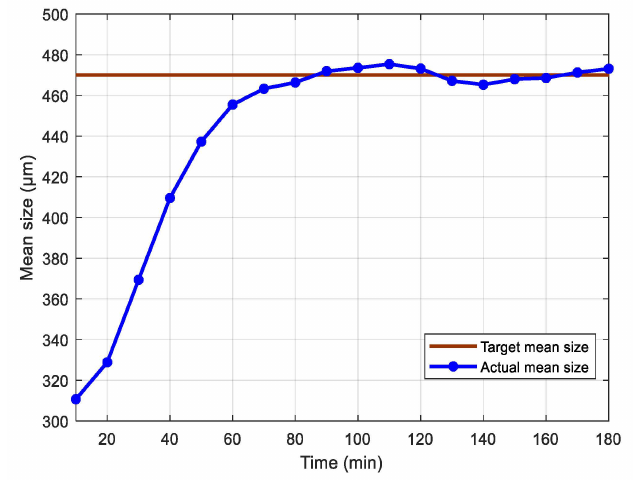
Figure 8. Mean crystal size profiles for NMPC.